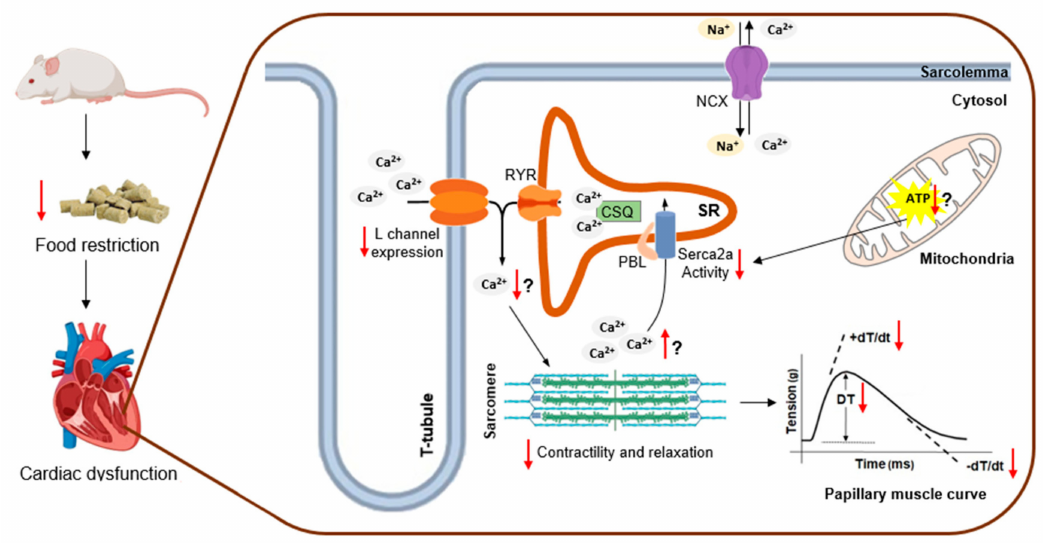
Figure 4. Overview of food restriction e ff ects over myocardium and presumable interactions between molecular changes and myocardial mechanical impairment. Food restriction reduced sarcoplasmic reticulum Ca 2 + -ATPase (SERCA2a) activity and L-type calcium channel (L channel) expression and impaired myocardial mechanical performance. Hypothetical adenosine triphosphate (ATP) depletion due to malnutrition could reduce the SERCA2a activity, leading to a high amount of residual cytosolic calcium. In turn, residual calcium signals to deplete the release of calcium by the ryanodine receptor (RYR), which is achieved by the reduced calcium entry secondary to the decreased protein expression of the L channel. This sequence of events involving the myocardial calcium handling would be a plausible mechanism by which the food restriction deteriorates the cardiac function. Ca 2 + , calcium; Na + , sodium; NCX, sodium-calcium exchanger; SR, sarcoplasmic reticulum; CSQ, calsequestrin; PLB, phospholamban; DT, developed tension; + dT / dt, positive tension derivative; − dT / dt negative tension